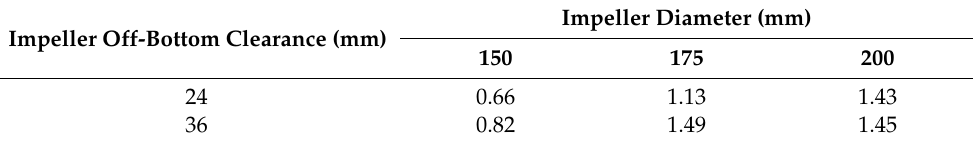
Table 4. Maximum resultant velocities (m · s − 1 ) of the radial and axial velocities at the related impeller diameter and off-bottom